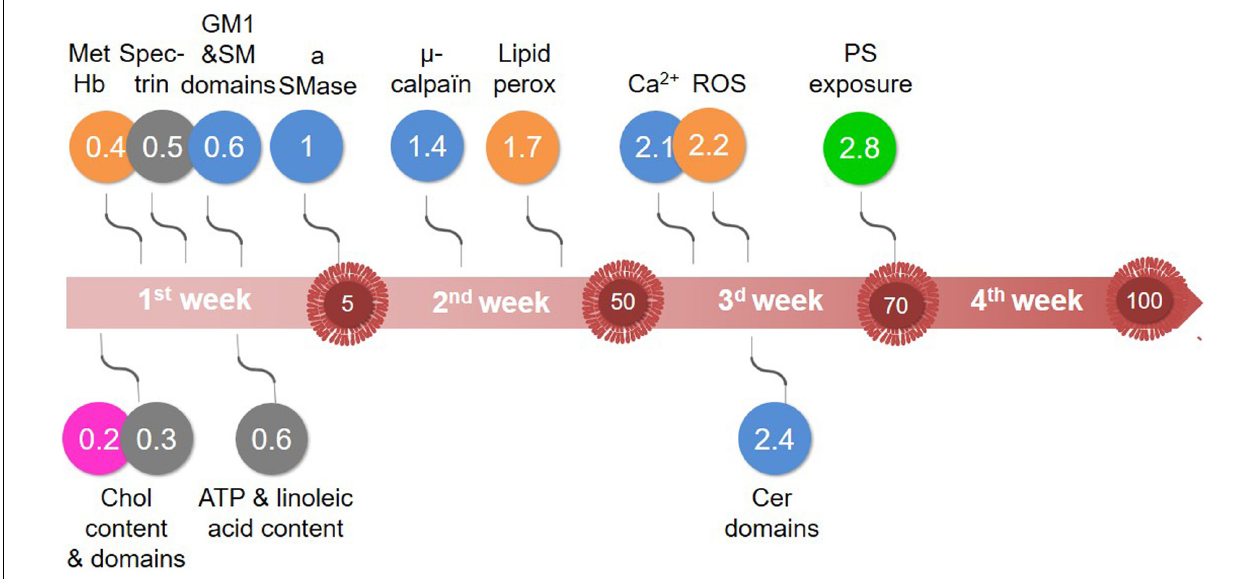
FIGURE 10 | Major vesiculation-related events that take place during RBC storage in K + /EDTA tubes. Although the sequence of events may depend on the sensitivity of assays used, our data indicate alterations of: (pink) chol-enriched domain abundance; (orange) oxidative stress; (blue) calcium content and aSMase activity, with the increase of sphingomyelin-enriched domains and the decrease of cer-enriched domains; and (green) membrane transversal asymmetry, with the increase of PS surface exposure. Those events are initiated by the rapid decrease of the intracellular ATP content and modifications of the membrane lipid content and the spectrin membrane occupancy (gray). The large red arrow depicts the storage period analyzed in this study. The numbers highlighted inside red EVs indicate the number of EVs released by RBC at the end of each week, as estimated in Figure 2E . Events depicted above the arrow are increased by half of their maximal increase at the time indicated in the colored circles. Events depicted below the arrow are decreased by half of their maximal decrease at the time indicated in the circles. For additional explanations, see